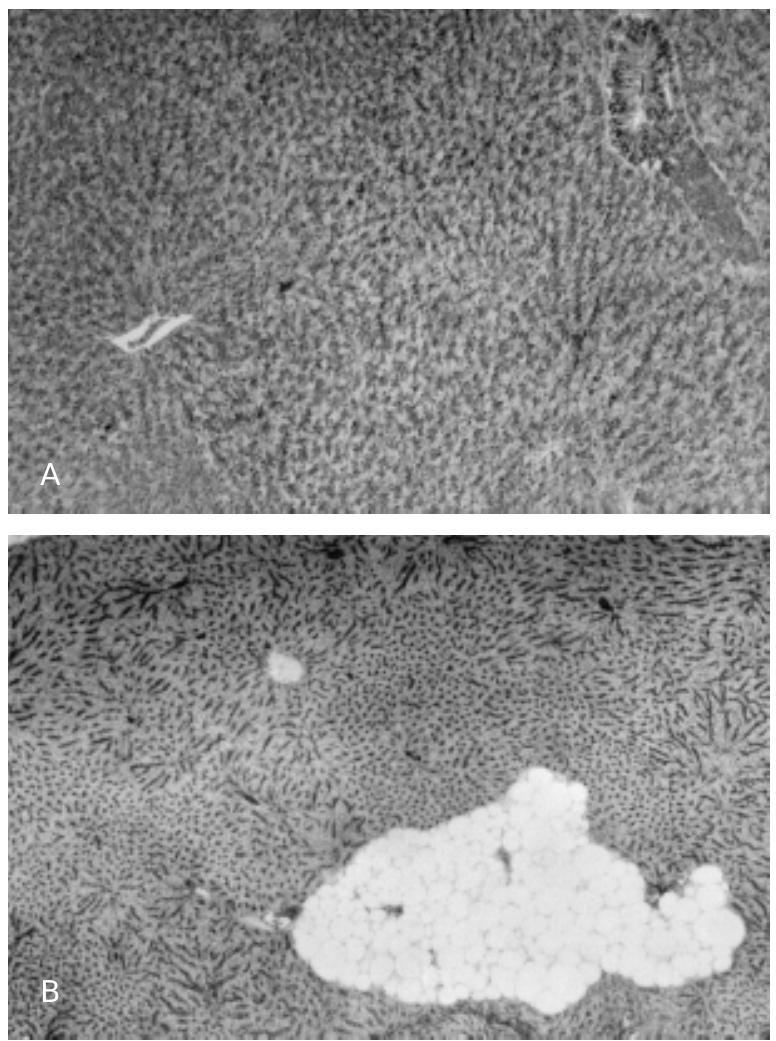
Figure 3. Microscopic view of the liver of Geophagus brasiliensis stained with hematoxylin- eosin, collected at a reference site (A; magnification, 100X) and at the polluted site (Benedito River) (B; magnification, 40X ). Lipid infiltration can be observed in B